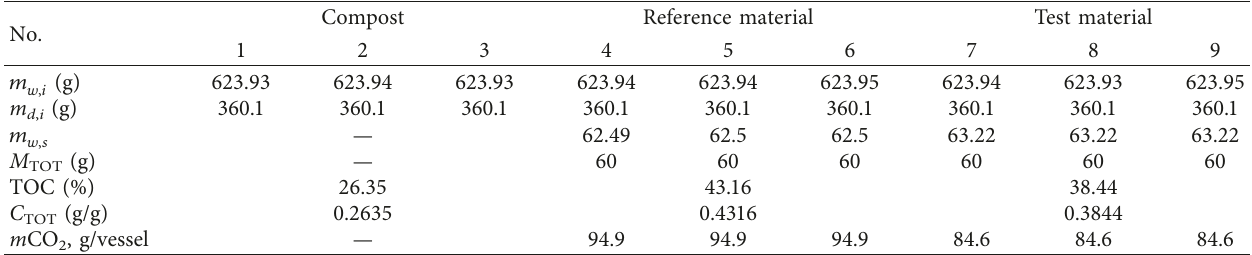
Table 2: Calculation of the theoretical amount of carbon dioxide ( m CO inoculum; m w,s is a wet solids of